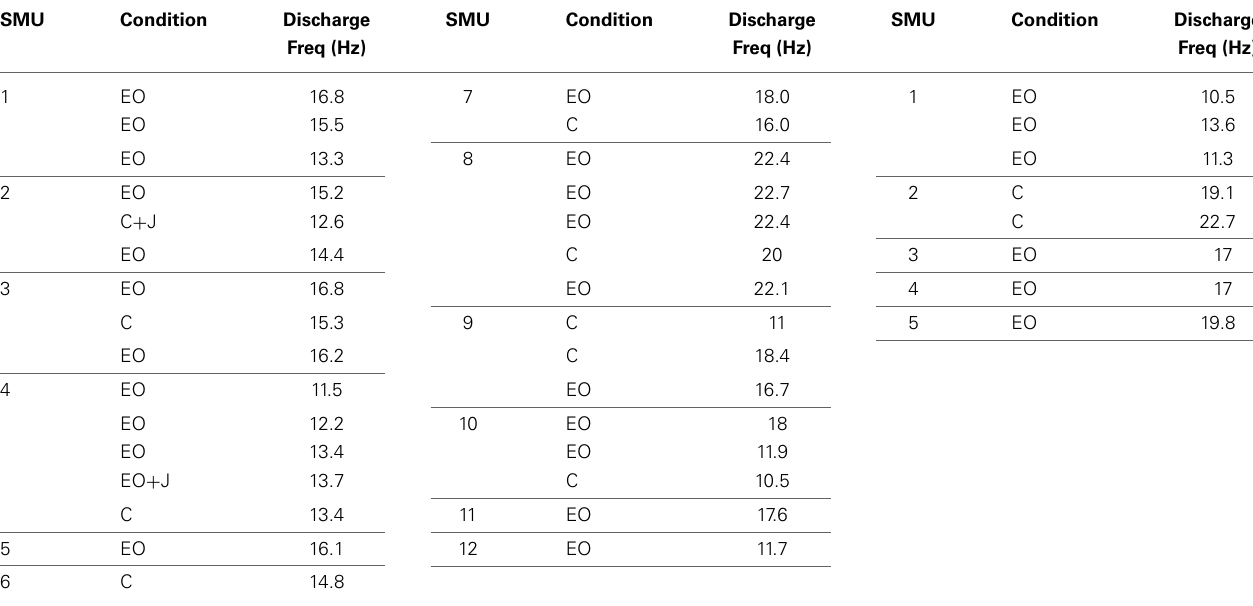
Table 1 | Condition and frequency information of